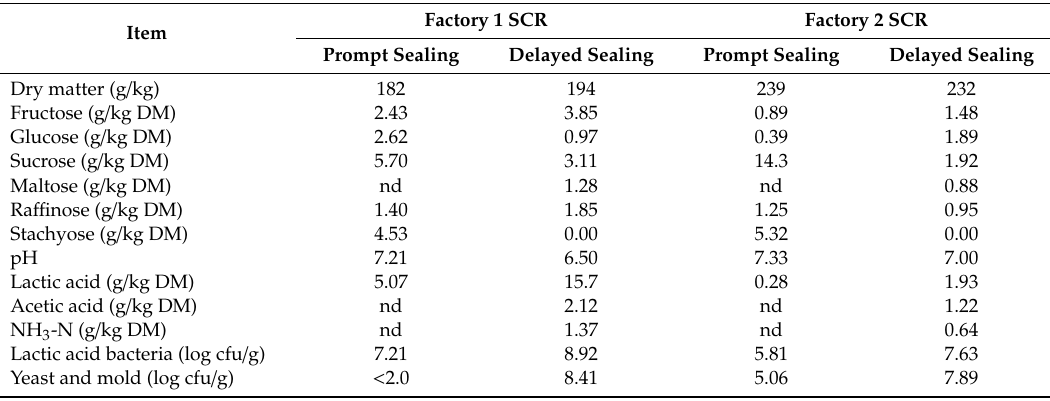
Table 1. Chemical composition and culturable microbiota count of soybean curd residue (SCR) used for ensiling study with prompt and delayed sealing.